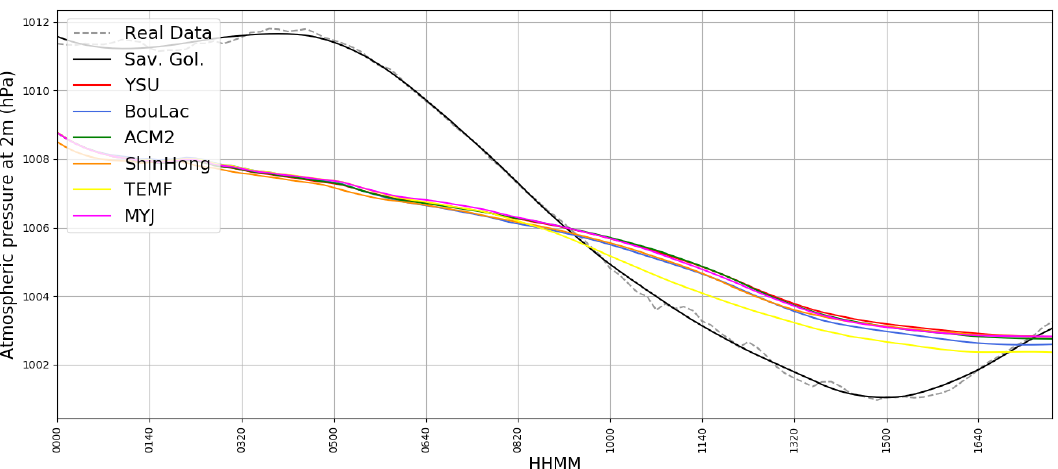
Figure 15. Simulated P2M timeseries compared with real GL P2M timeseries, 04 / 04 / 2016, dotted grey: real data, black: Savitsky–Golay smoothing of real data, red: simulated data with YSU parametrization, blue: simulated data with BouLac parametrization, green: simulated data with ACM2 parametrization, orange: simulated data with ShinHong parametrization, yellow: simulated data with TEMF parametrization, purple: simulated data with MYJ parametrization.